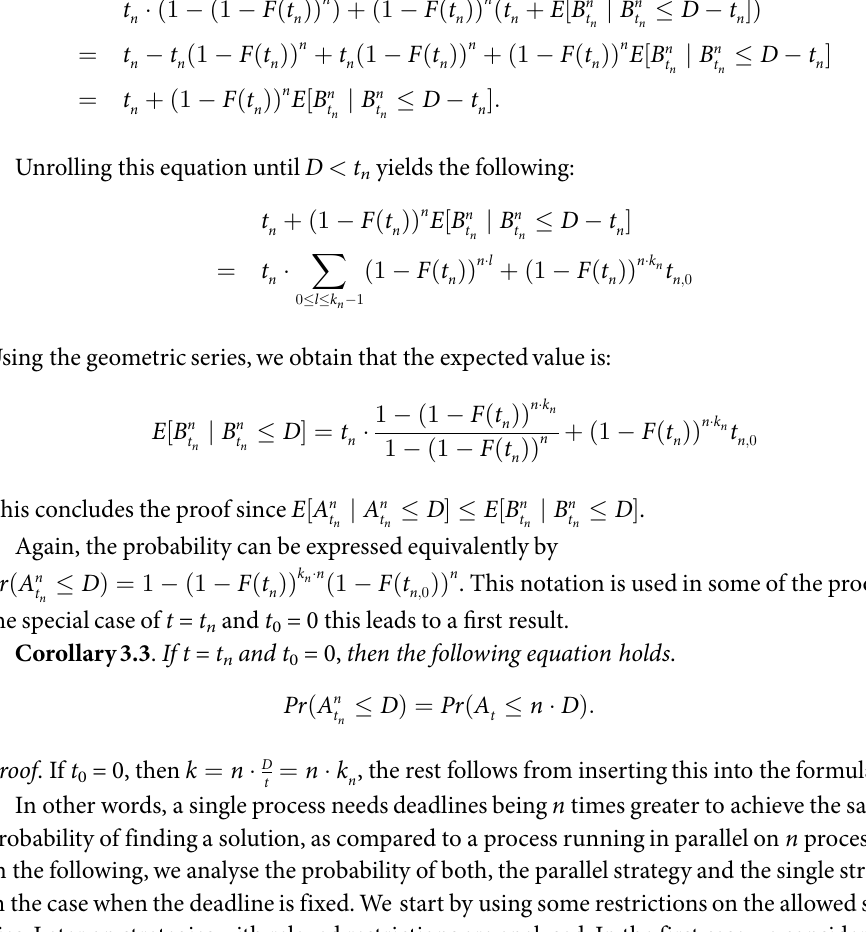
steps where 1 (cid:20) l (cid:20) k n